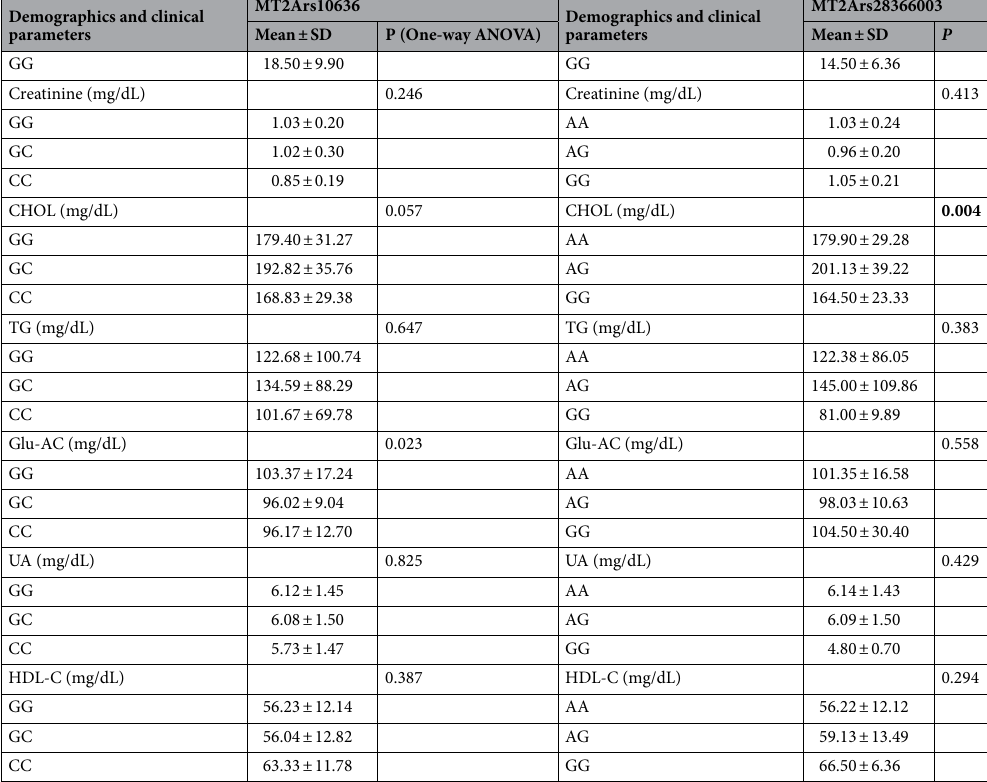
Table 2. MT2Ars10636 and MT2Ars28366003 genotype distributions in demographics, clinical parameters of residents in Taiwan. RBC Red blood cell, HgB Hemoglobin, Hct Hematocrit, WBC White blood cell, MCV Mean corpuscular volume, MCH Mean corpuscular hemoglobin, MCHC Mean corpuscular hemoglobin concentration, PLT Platelet, Lym Lymphocytes, Seg Segment, Mono Monocytes, Eosin Eosinophils, GOT in [bold].